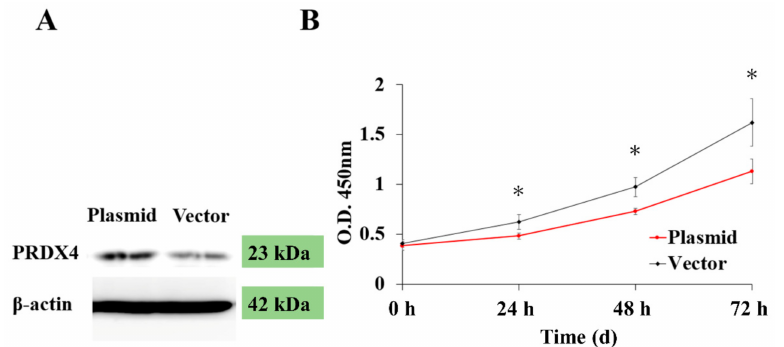
Figure 4. Western blotting and cell proliferation A: The protein expression of PRDX4 was remarkably increased after transfection of PRDX4 plasmid in K-1. B: The proliferation of K-1 cells was analyzed using a CCK-8 kit, 3 days after the transfection of PRDX4 plasmid DNAs or negative vectors. Plasmid, PRDX4 plasmid DNA; Vector, negative control vector; * t -test, p <